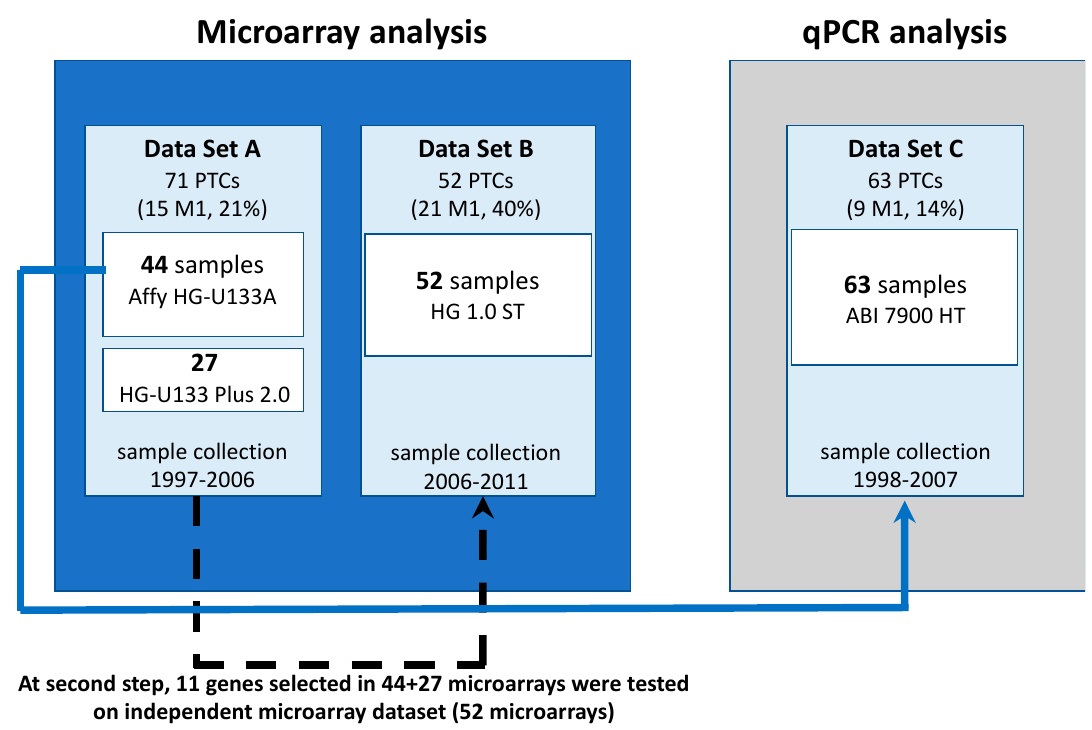
Figure 1. Study scheme. The set C is highlighted by a different color of the background to emphasize our resignation from this analysis during the further study course.